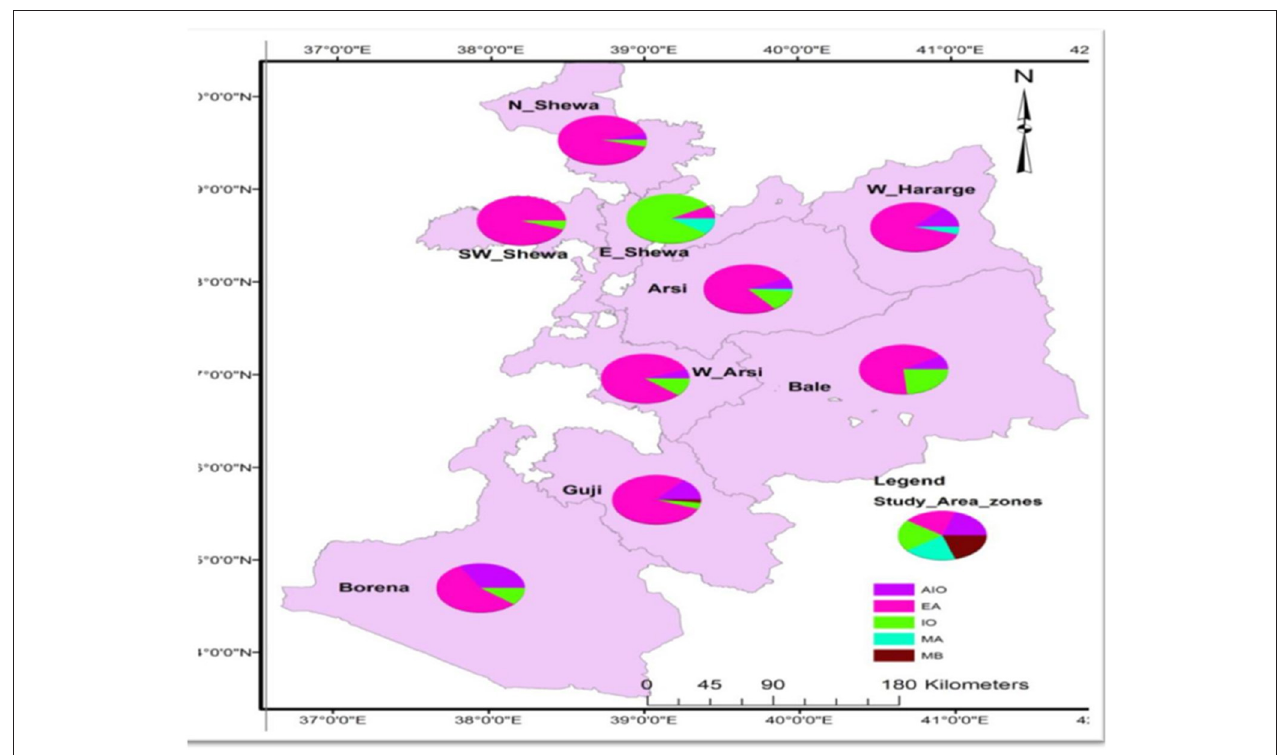
FIGURE 2 | Map showing proportion of major lineages of MTB strains per zones circulating in Oromia, 2020. EAI, East-African-Indian; EA, Euro-American; IO, Indo-Oceanic; MA, M. africanum ; MB, M. bovis ; N_Shewa, North Shewa; W_Hararge, West hararge; SW_Shewa, South West Shewa; E_Shewa, East Shewa; W_Aersi, West